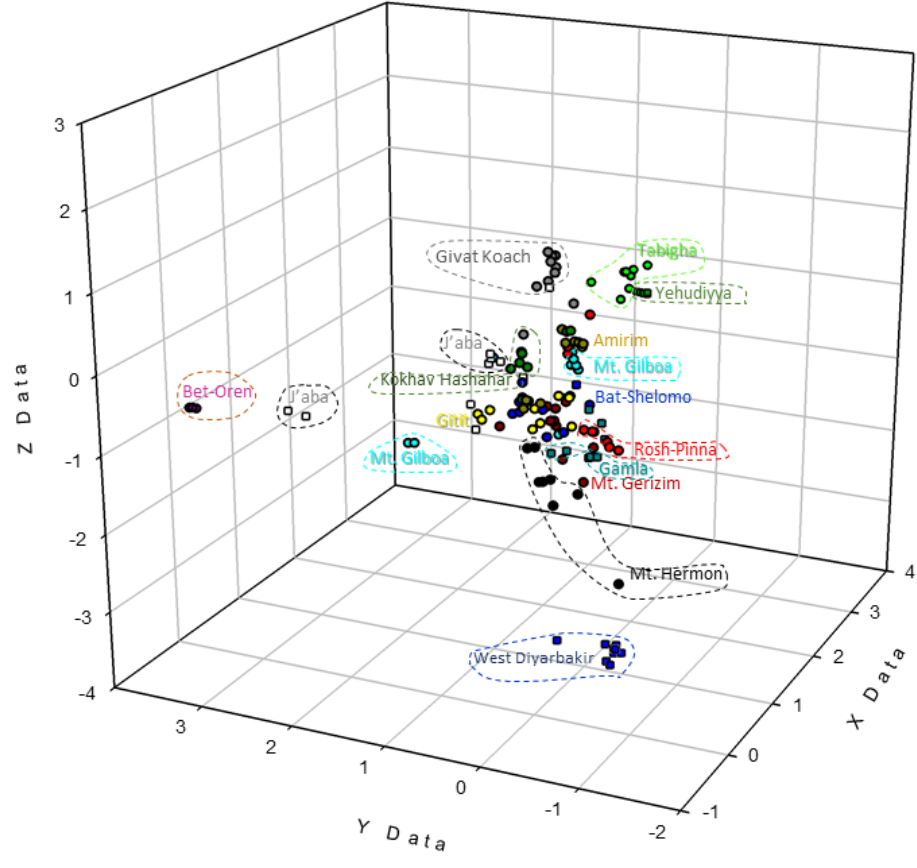
Figure 5. Principal component plot for the 15 WEW populations. The populations are labeled as follows: dark yellow circles, Amirim; dark blue circles, Bat-Shelomo; dark pink circles, Bet-Oren; red circles, Rosh-Pinna; light green circles, Tabigha; dark green boxes, Yehudiyya; dark cyan boxes, Gamla; black circles, Mt. Hermon; white boxes, J’aba; dark green circles, Kokhav Hashahar; cyan circles, Mt. Gilboa; dark red circles, Mt. Gerizim; light yellow circles, Gitit; grey circles, Givat Koach; dark blue boxes, West Diyarbakir. Accessions from individual populations that were clustered by the first three principal components are circled and labeled.